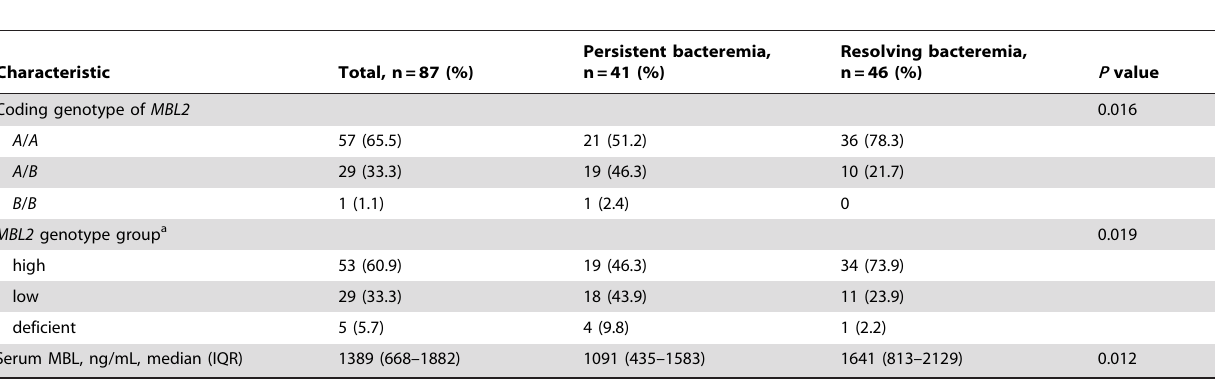
Table 3. Comparison of MBL2 genotypes and serum MBL levels in patients with persistent bacteremia and resolving bacteremia caused by Staphylococcus aureus .